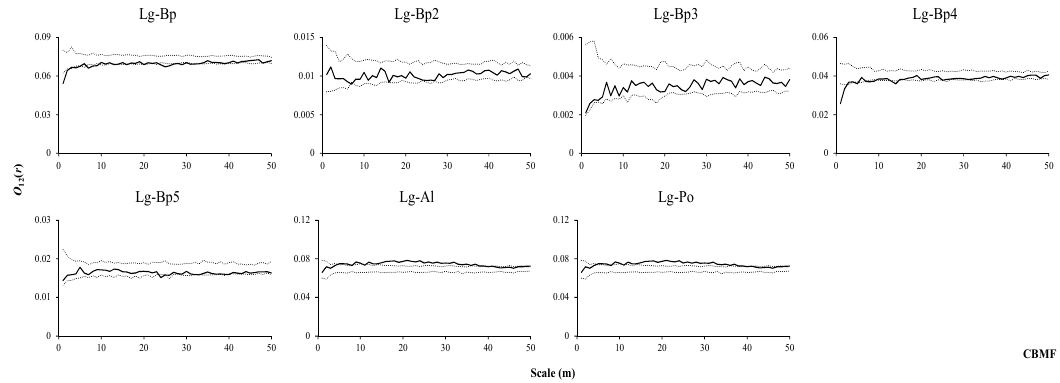
Forests 2020 , 11 , 152 13 of 18